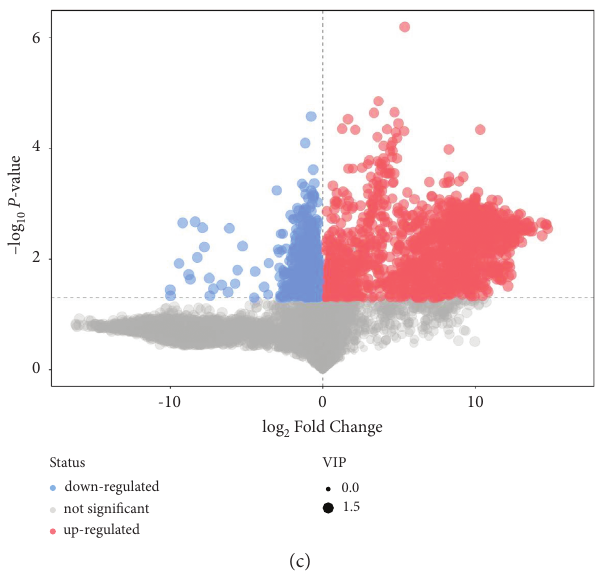
Figure 3: Screening volcano plot of differential lipids between the two groups of rats with different feedary interventions (positive ion mode). (Remarks: (a) high-fat feed group vs. high-dose reconstituted rice group; (b) high-fat feed group vs. ordinary rice group; and (c) high-dose reconstituted rice group vs. ordinary rice